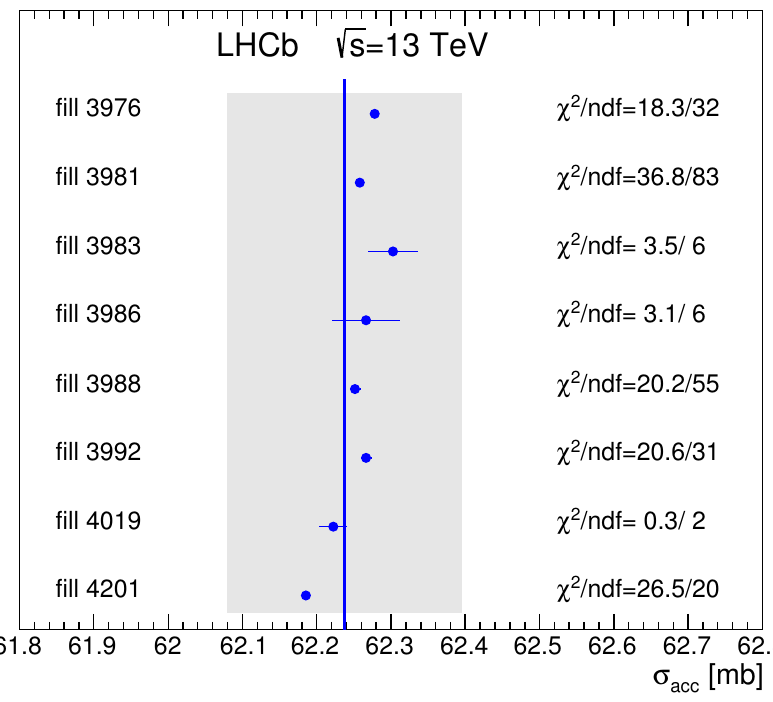
Figure 1 . Overall (cid:12)ducial cross-section (vertical line), compared to the averages of the individual results in di(cid:11)erent LHC (cid:12)lls. The error bars indicate the statistical uncertainties. The grey band indicates the systematic uncertainty on the overall average due to the unfolding parameter (cid:11) . The (cid:31) 2 -values for the averages inside a (cid:12)ll are calculated with only the statistical uncertainties and the number of degrees of freedom (ndf) is one less than the number of individual results contributing to the average. Systematic uncertainties inferred from the observed spread between the (cid:12)lls are discussed in the